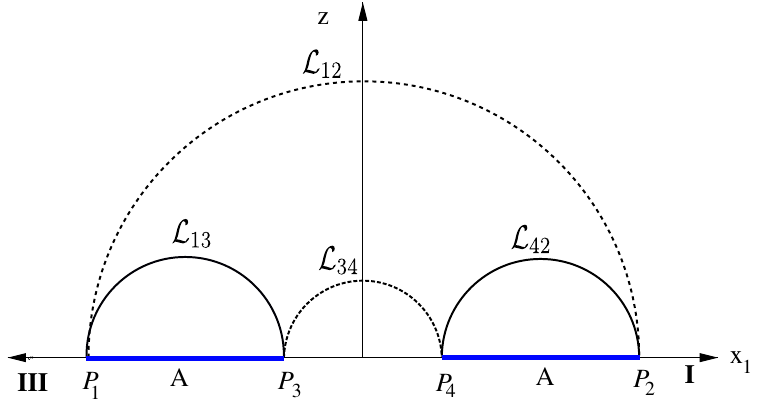
Figure 4 . Geodesics configuration for a single interval projected into the x 1 , z plane. For early time geodesics are shown by the dotted lines and for large time geodesics are shown by the solid lines (figure modified from that in